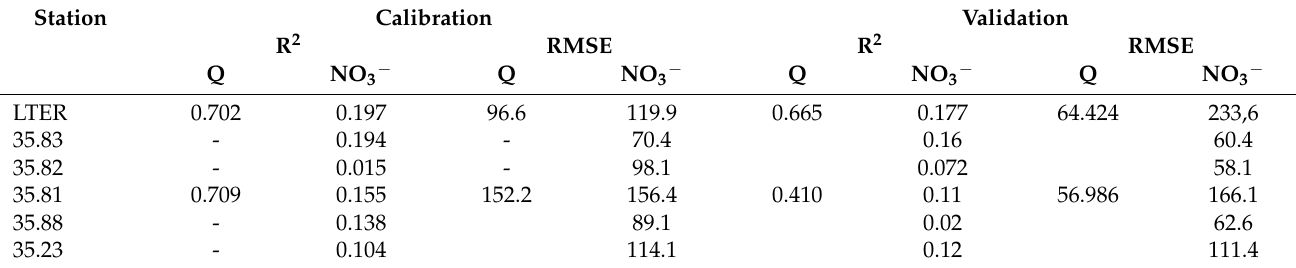
Table 3. Goodness-of-fit values of PERSiST and INCA model application.